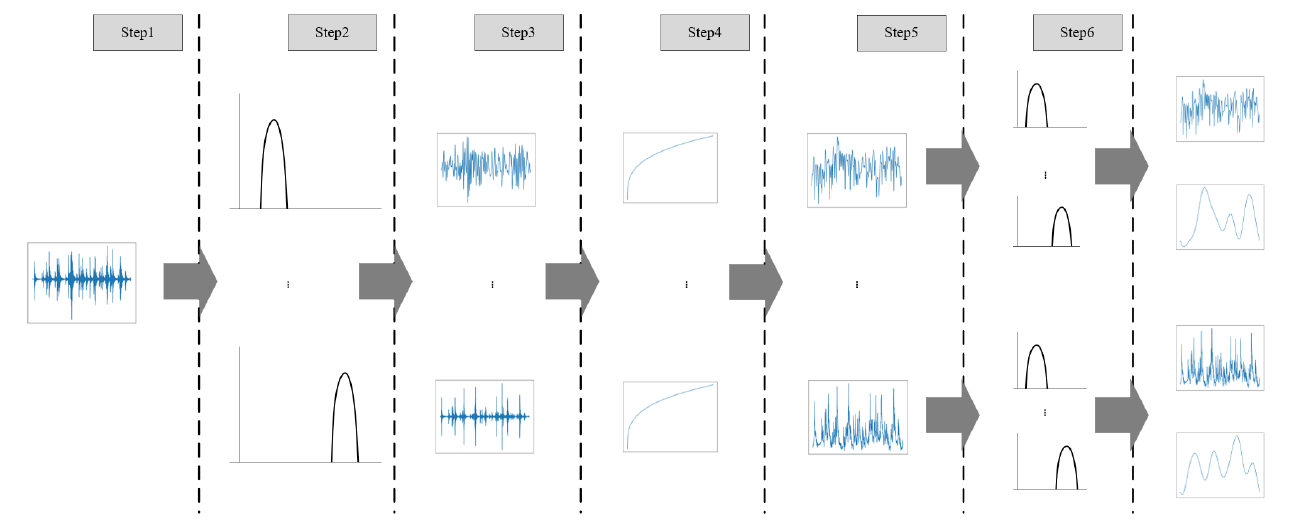
Figure 2. The specific process of obtaining sound texture from original